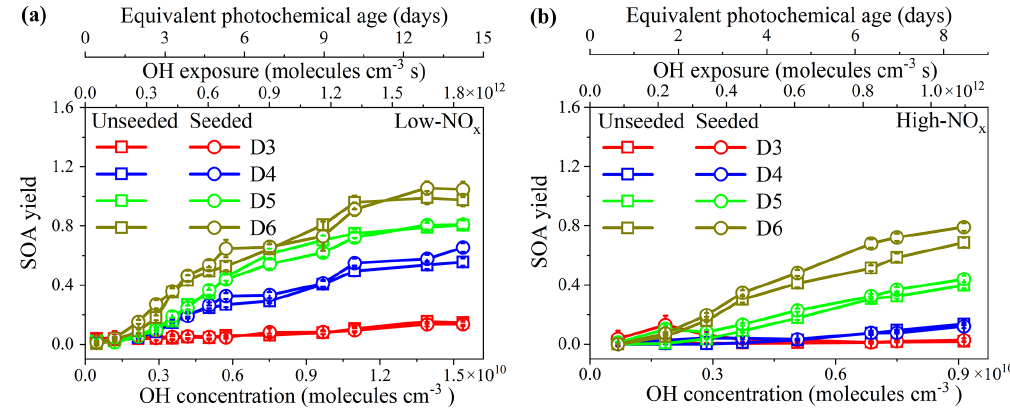
Figure 1. SOA yields from unseeded and seeded (30µgm − 3 ) photooxidation of cVMSs by OH radicals. (a) low-NO x experiments; (b) high- NO x